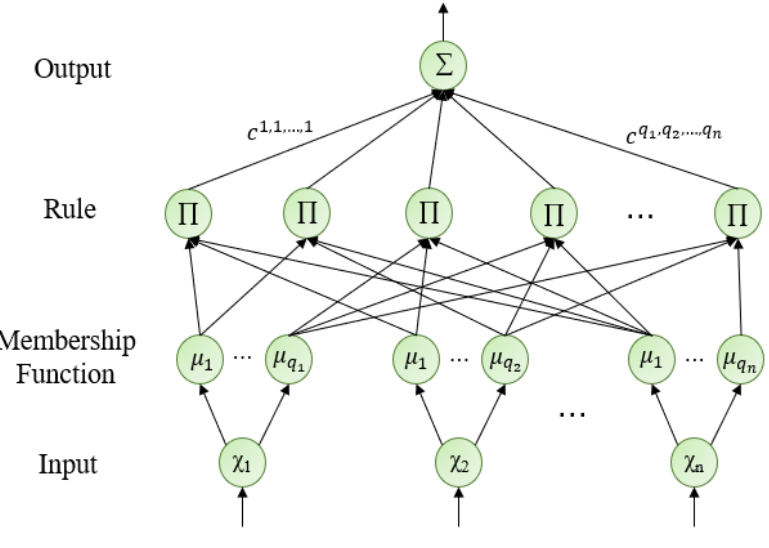
Figure 1. IMRO structure of